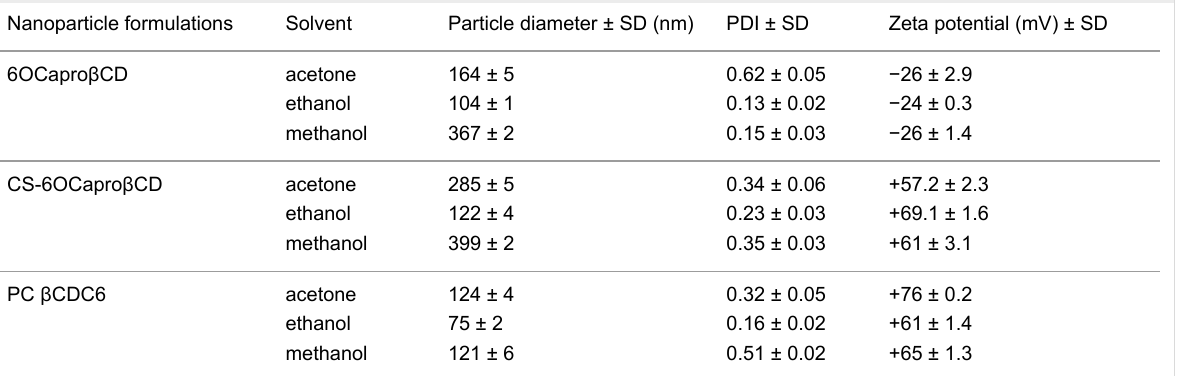
Table 1: Effect of organic solvent on mean particle size, PDI and zeta potential values of formulations (CD amount is 0.5 mg/mL in all formulations) ( n = 3, ± standard deviation (SD)). Nanoparticle